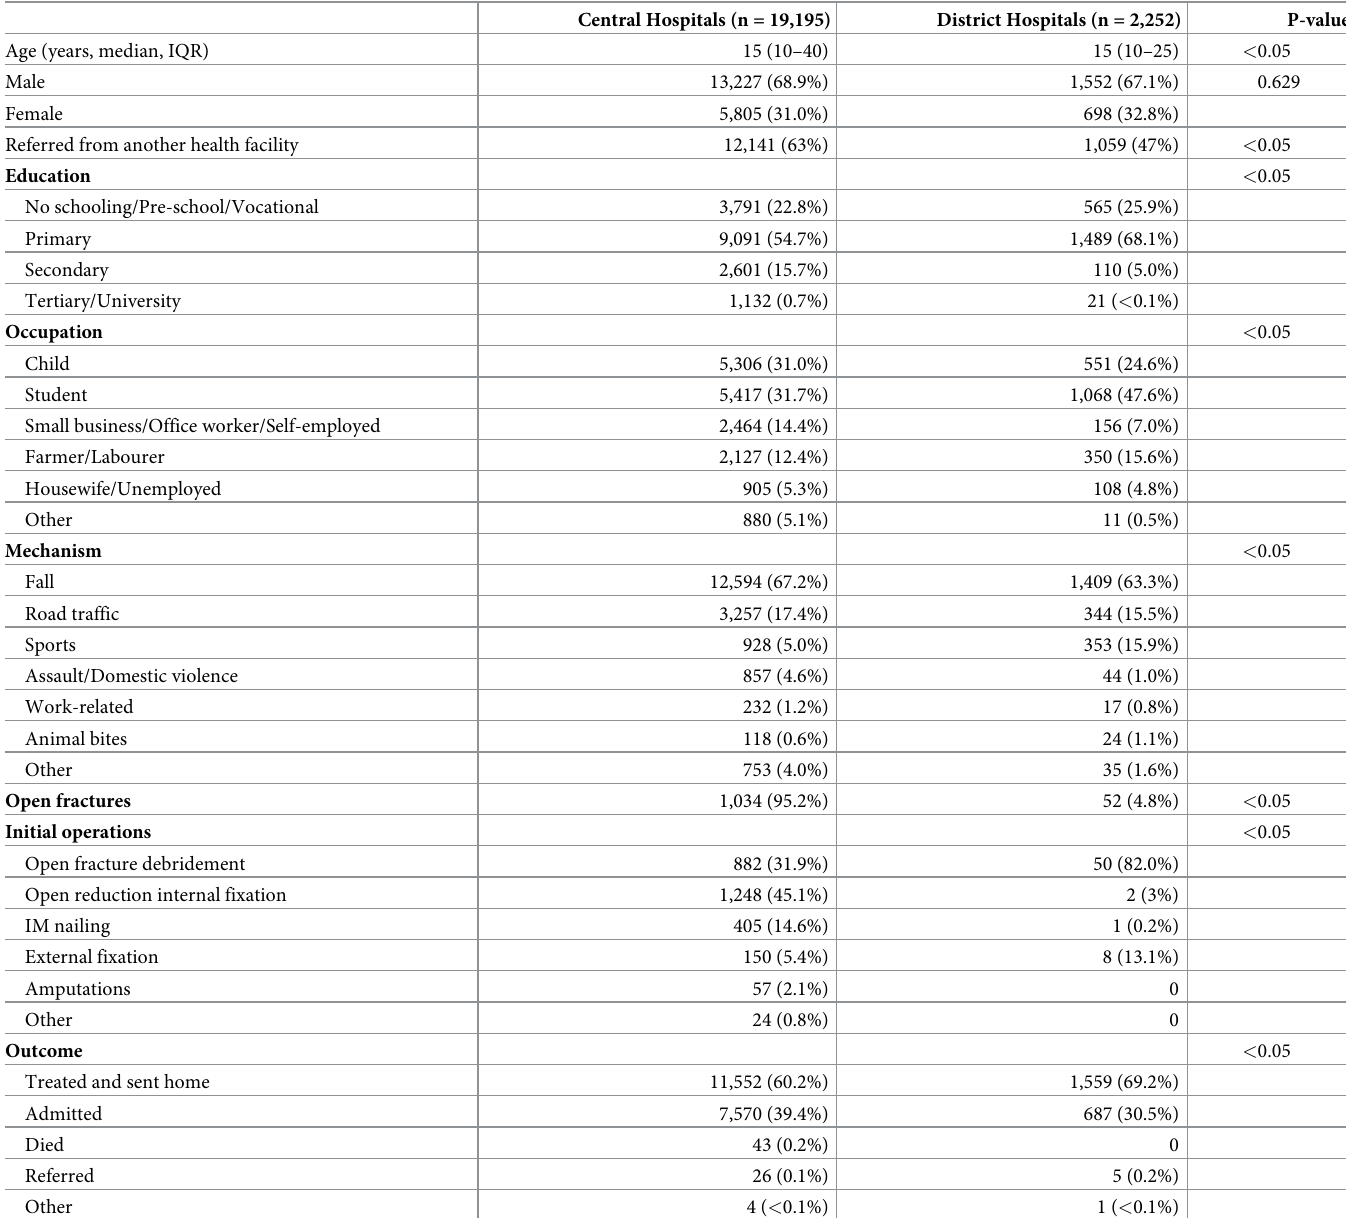
Table 1. Characteristics of fractures presenting to Malawi between